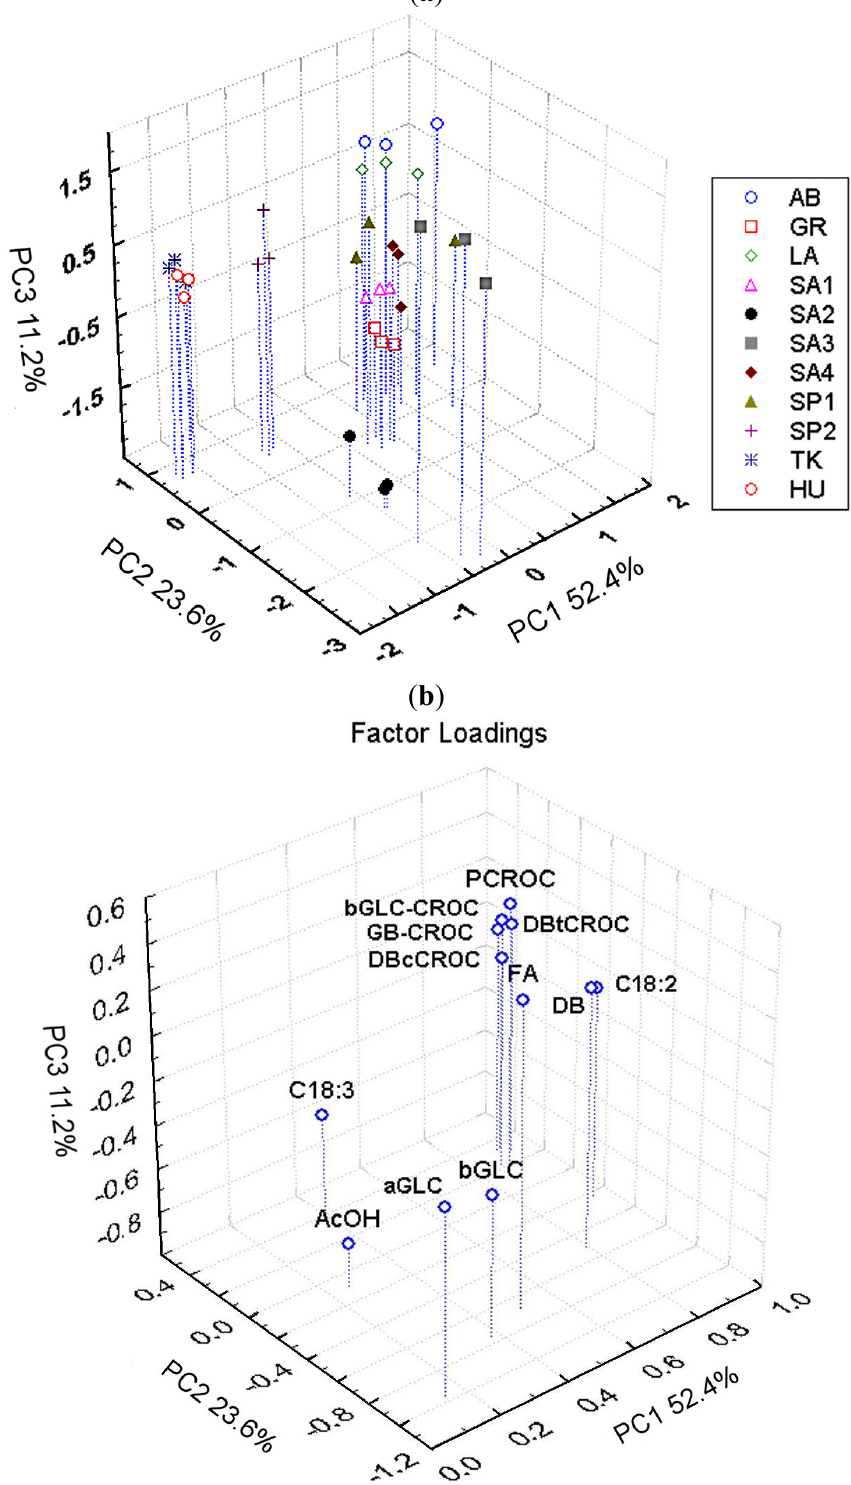
Figure 6. ( a ) PCA performed on 12 metabolite levels measured in saffron extracts of different geographical origin sample scores plot; ( b ) PCA plot of